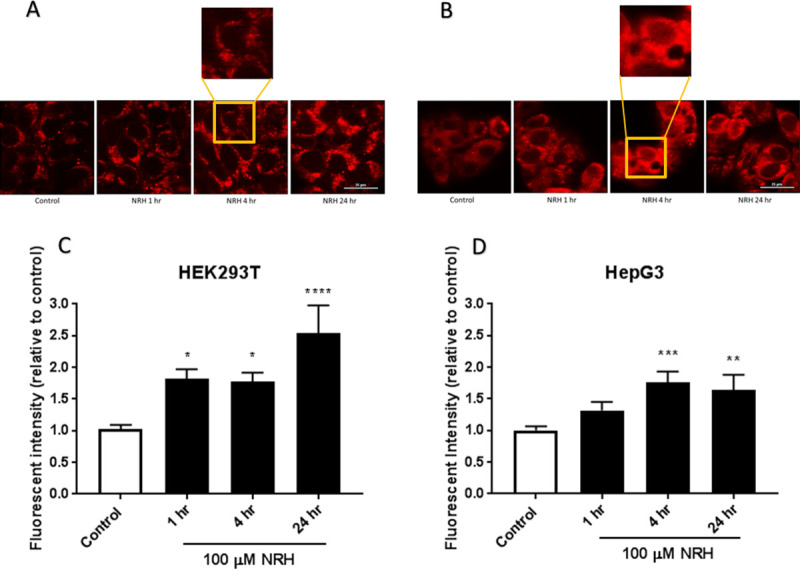
NRH exposure increased NADH/NADPH levels in HEK293T and HepG3.Autofluorescent images of endogenous NAD(P)H in untreated and 100 μM NRH exposed (A) HEK293T and (B) HepG3 cells. Quantification of fluorescent signal for untreated and 100 μM NRH treated (C) HEK293T, and (D) HepG3 cells. Results are expressed as the mean intensity of the fluorescent values relative to the control ± SEM calculated from three biological replicates. Statistically significance: * P < 0.05, ** P < 0.01, *** P < 0.005 and **** P < 0.001. Representative images are shown in part A and B from one of the three replicates, scale bars: 25 μm.